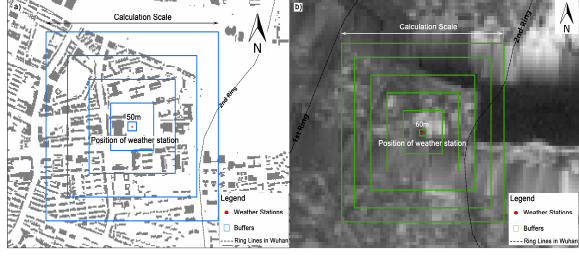
Fig 2. Square sizes for BD (a)) and NDVI (b))